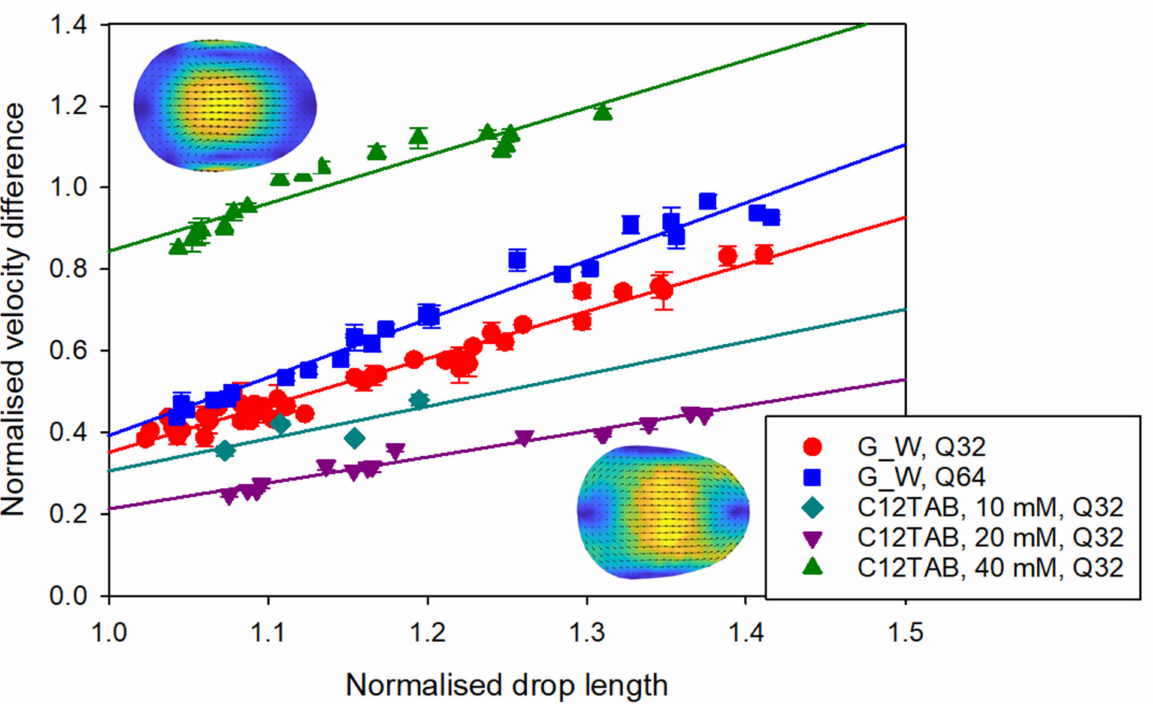
Figure 7. Dependence of normalized velocity difference in the middle plane on normalized drop length for surfactant-free dispersed phase and various concentrations of C 12 TAB. Q32 corresponds to the total flow rate Q = 32 µ L/min, and Q64 corresponds to the total flow rate Q = 64 µ